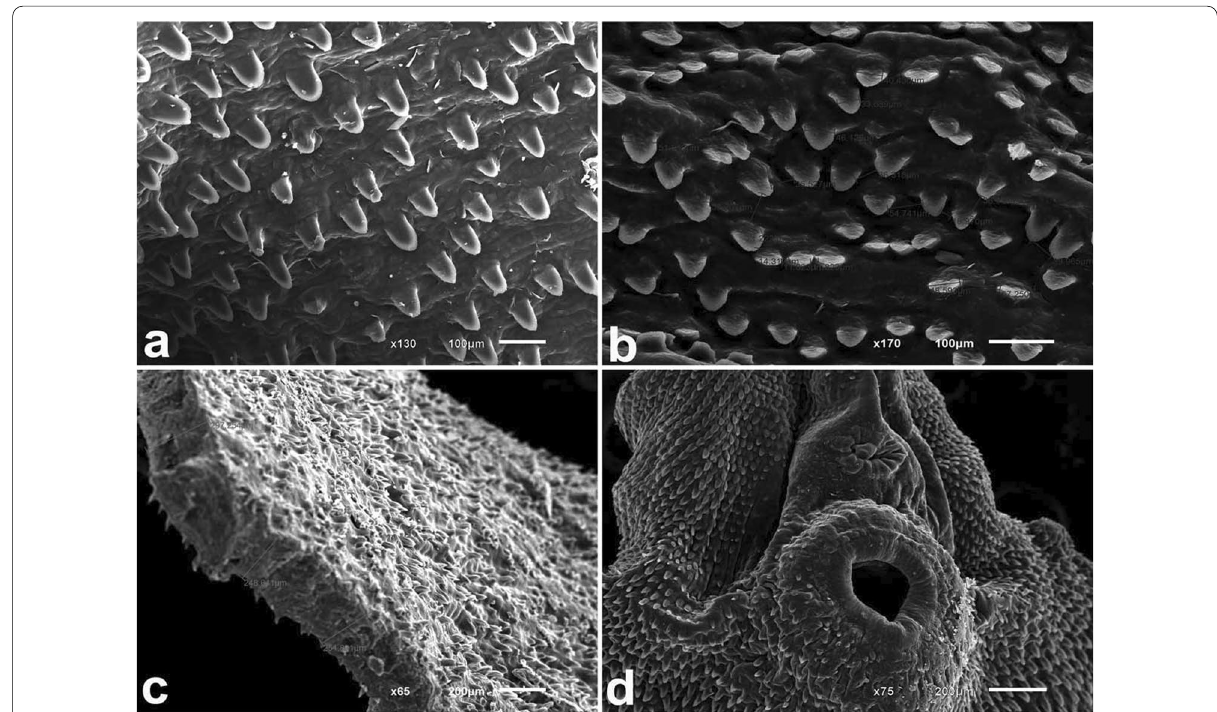
Fig. 1 SEM of control untreated Fasciola gigantica adult worms. a , b Intact spines on the dorsal and ventral surfaces. c The tegument thickness 248–297 µm. d Ventral sucker ranged from 238–318